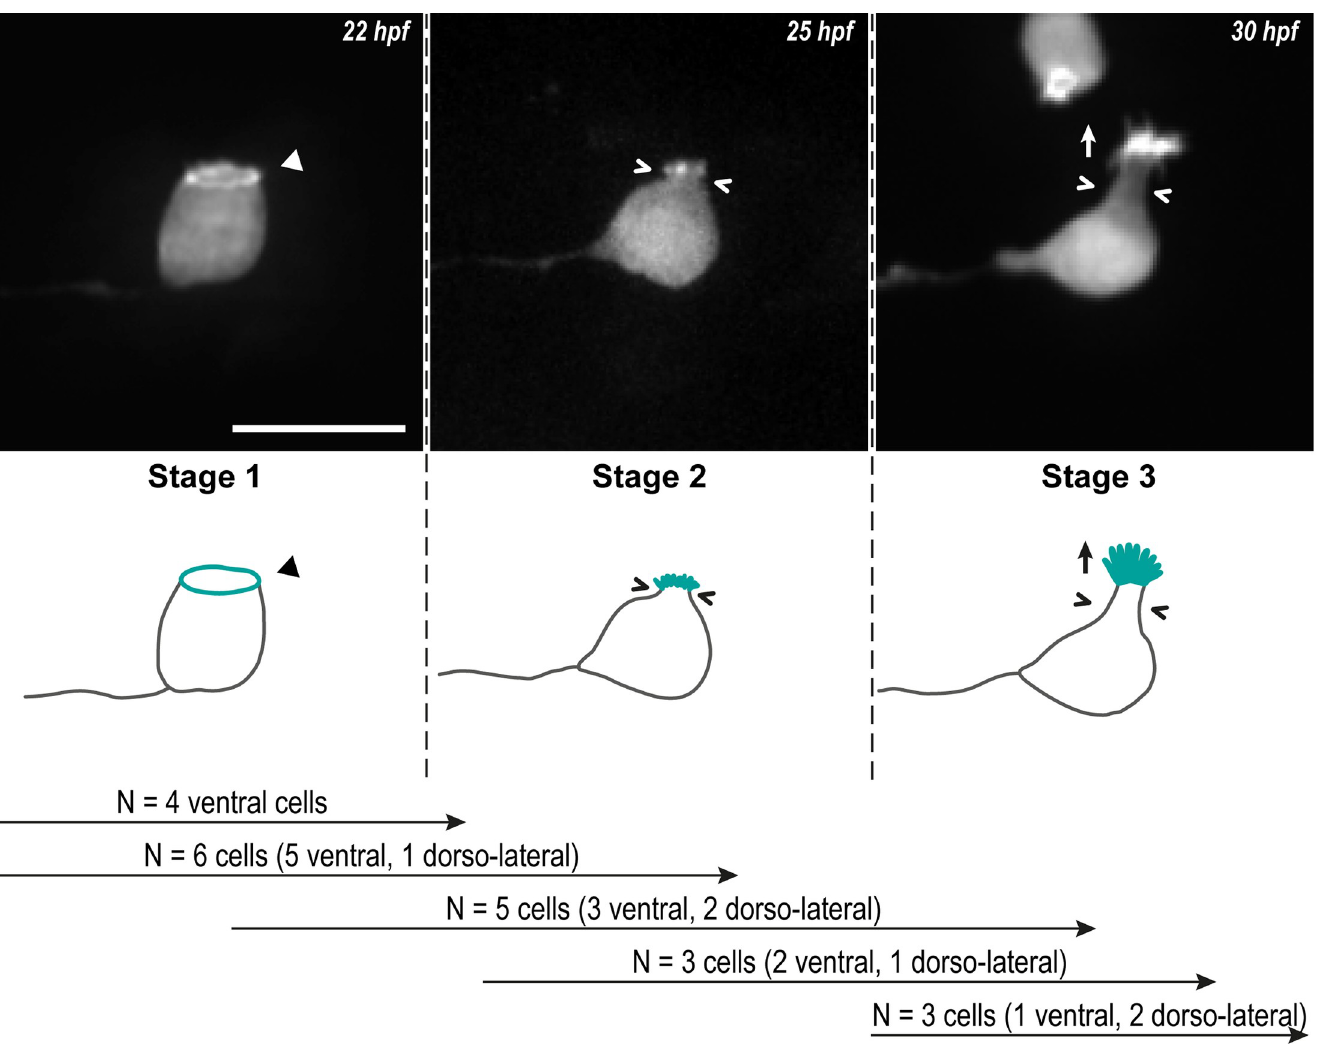
Fig 1. CSF-cNs go through 3 critical steps to form their apical extension. Z-projections from time-lapse acquisitions (top panels; lateral views of ventral CSF-cNs with rostral to the left) and schematics (bottom panels) showing the 3 stages CSF-cNs go through during the formation of their AE. The CSF-cN soma becomes round and short actin-based protrusions (Stage 2) arise from the ring of actin (Stage 1, arrowhead) concomitantly with a subapical constriction (Stages 2 and 3; chevrons). Gradually, protrusions lengthen to form the AE (Stage 3; arrow) characteristic of differentiated CSF-cNs. Data collected over 13 time-lapse sessions for 15 ventral and 6 dorsolateral cells. The number of cells imaged transitioning from one stage to the next is indicated in the bottom legend. Scale bar, 10 μ m. AE, apical extension; CSF-cN, cerebrospinal fluid-contacting neuron. hpf, hours post fertilization.